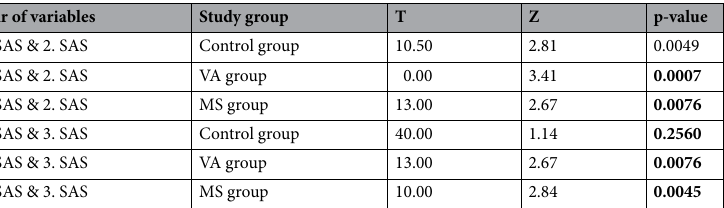
Table 2. Comparison of the sizes of the surface areas in the study with eyes open and with eyes closed. SAS surface area of the stabilogram, AV atrial vertigo, MS multiple sclerosis, VCI vision control index, VMCI